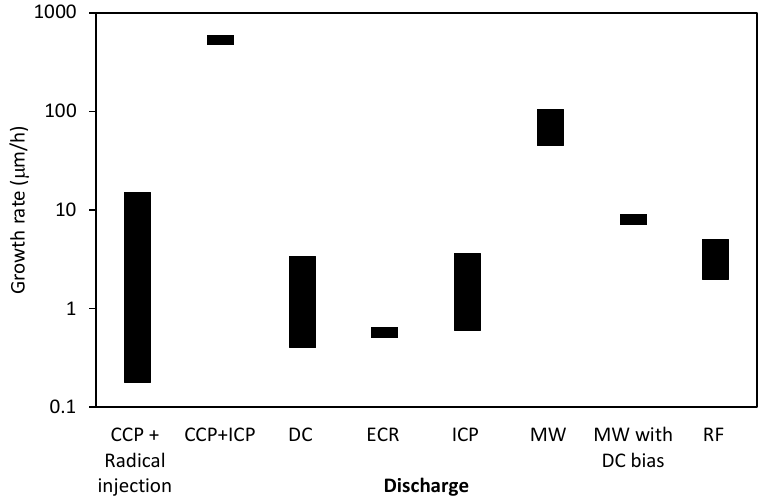
Figure 5. The growth rate for different types of discharges as reported in literature shown in Table 1. The height of the bars indicates the range of growth rates found in the literature.